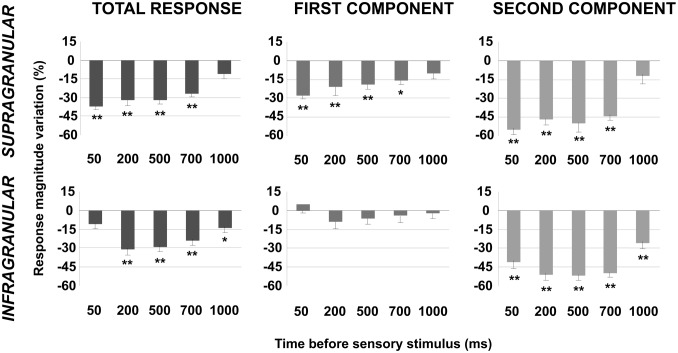
The effect of POm E-stimulation is time-dependent.This figure shows the change in mean sensory response magnitude by different POm E-stimulation intervals (50–1000 ms) before whisker stimulus. Supragranular total response was significantly reduced by POm E-stimulation at intervals ranged from 50 to 700 ms but not at 1000 ms. Total response of infragranular neurons was reduced at intervals from 200 to 1000 ms but not at 50 ms. In infragranular layers, the first response component (from onset to 20 ms) was not significantly affected at any time interval. In contrast, in supragranular layers, spikes in the first component were reduced at intervals <1000 ms. Spike reduction by POm E-stimulation was more prevalent in the second component of the responses in both layers (from 20 ms to offset). In supragranular neurons, spikes in the second component were decreased significantly at several time intervals from 50 to 700 ms before stimulus. The most powerful effect was found at 50 ms. Spikes in the second component of infragranular neurons were reduced significantly at time intervals from 50 to 1000 ms before sensory stimulus. In infragranular layer, the numbers of single units analyzed in each interval are: n = 38 (50 ms), n = 40 (200 ms), n = 80 (500 ms), n = 55 (700 ms) and n = 40 (1000 ms). In supragranular layer, n = 35 (50 ms), n = 33 (200 ms), n = 67 (500 ms), n = 45 (700 ms) and n = 32 (1000 ms). In all figures: * P<0.05; ** P<0.01.